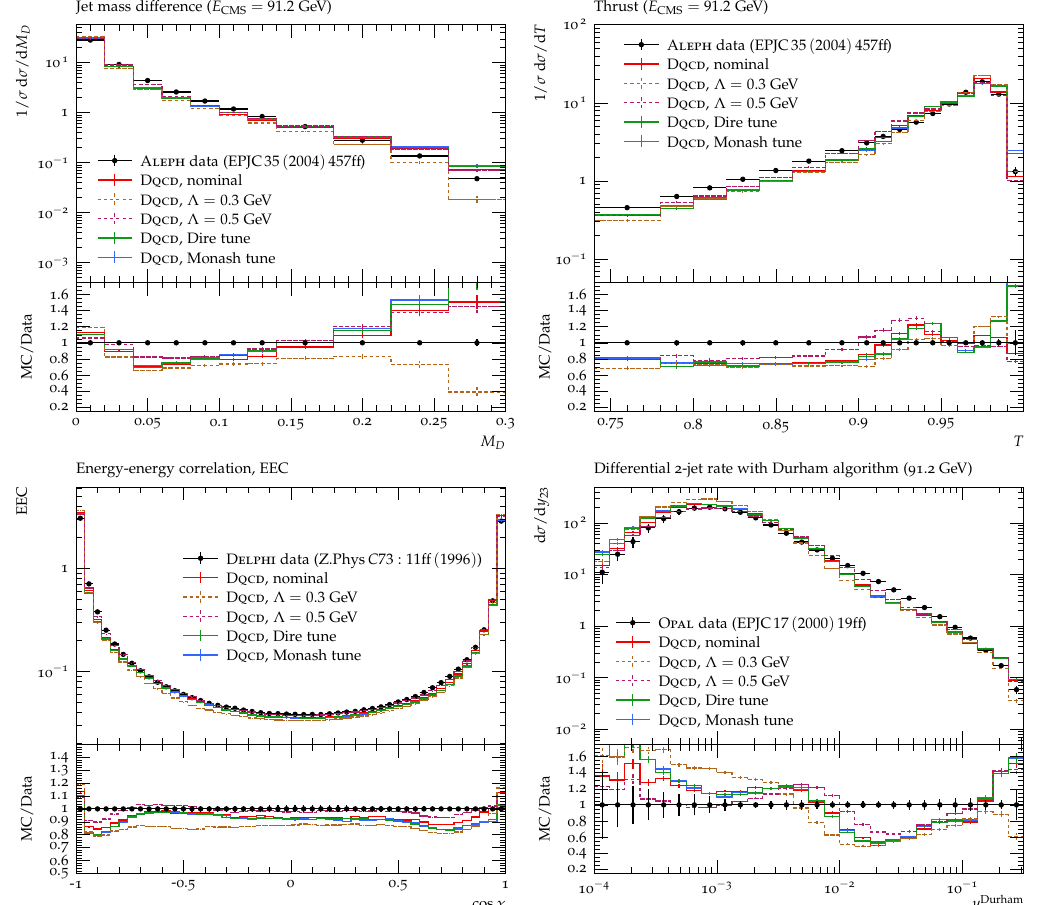
Figure 9. Sample comparisons of the Discrete QCD model for varying values for the mass scale Λ . This leads to non-negligible uncertainties for observables that are dominated by perturbative QCD, as expected from a leading-logarithmic